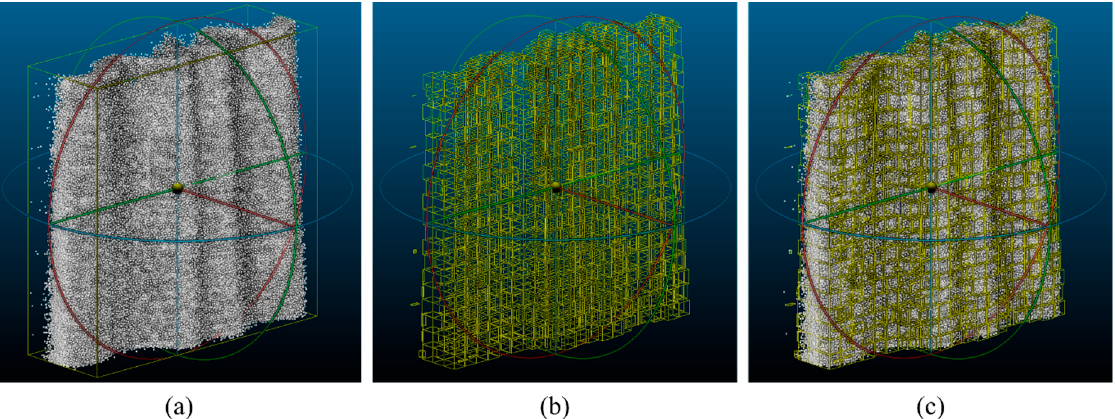
Figure 5. ( a ) Raw PCD; ( b ) Space decomposition; ( c ) Voxels. PCD: Point Cloud Data.